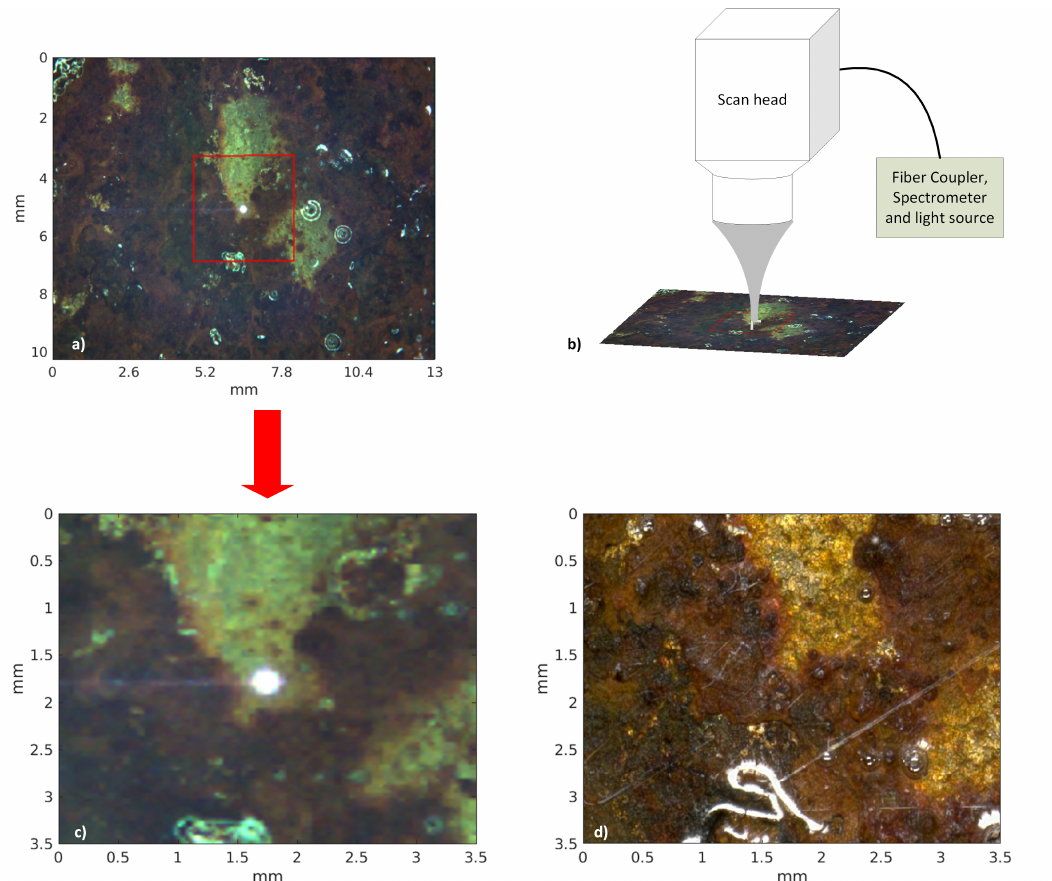
Figure 1. ( a ) Snapshot taken with the in-built camera of the optical coherence tomography (OCT) system of a standard sample; ( b ) measurement schematic; ( c ) interpolated video image; ( d ) microscopic image of the region of